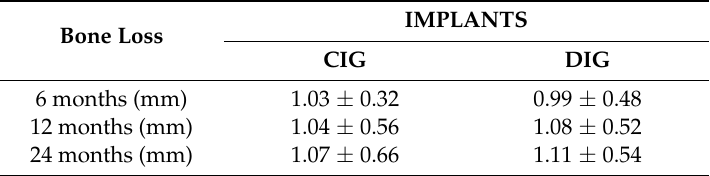
Table 3. Crestal bone loss values (mean ± SD) for tilted and upright implants of both groups (CIG = conventional impression group; DIG = digital impression group) (CIG n = implant = 150; DIG n = implant =